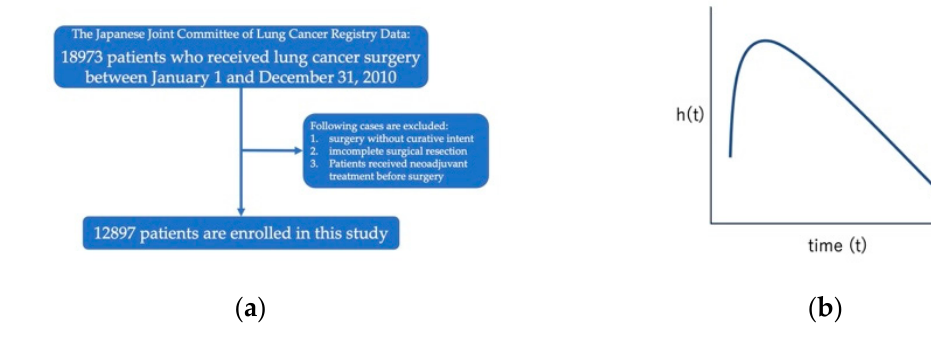
Figure 1. ( a ) Study flowchart. ( b ) Model of hazard function